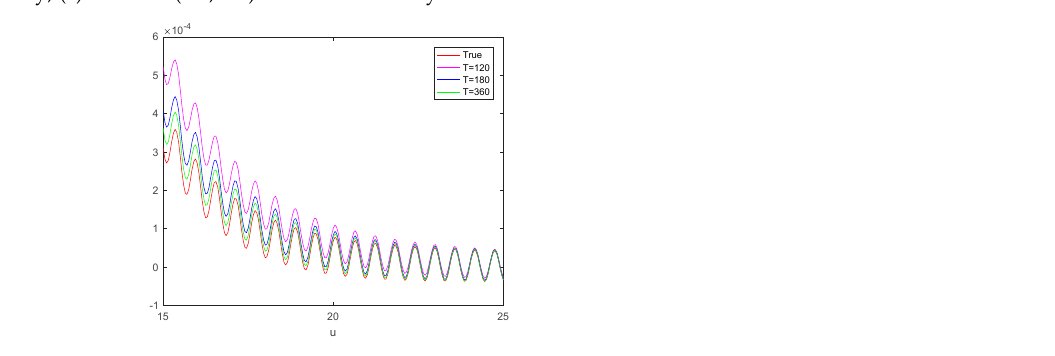
Figure 6. A partial enlargement of the mean curves for the estimation of the ruin probability under the Gamma (1.5, 1.5) distribution.